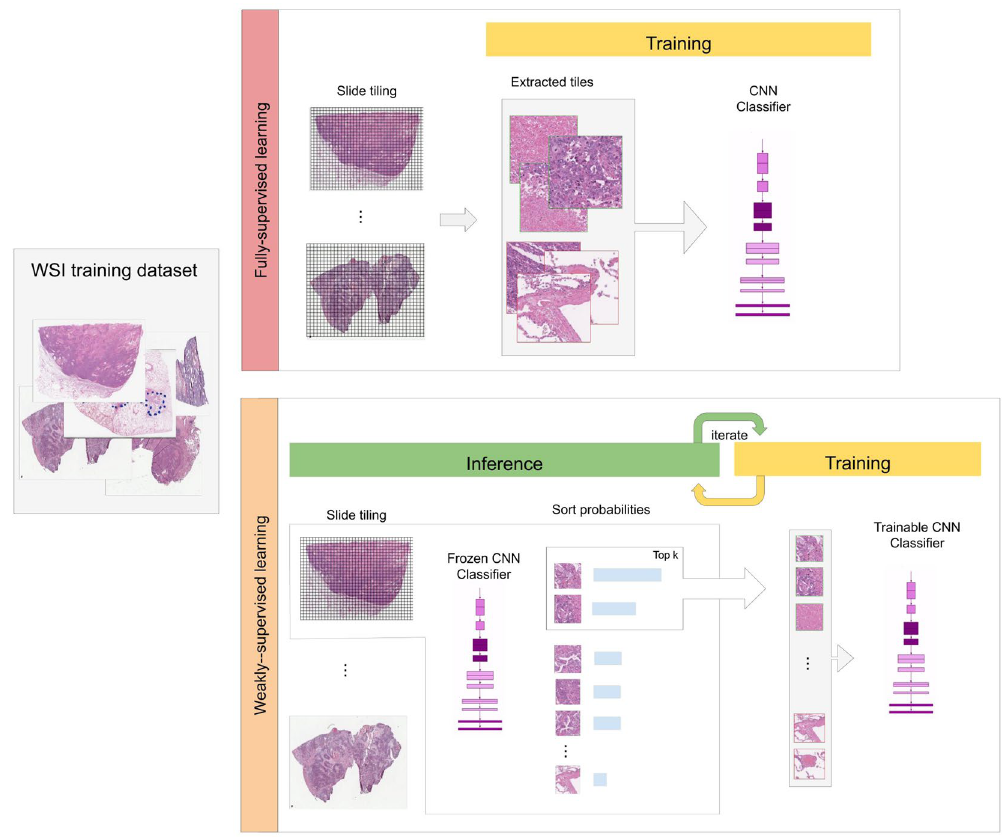
Figure 7. Overview of the two training methods: fully-supervised learning and weakly supervised learning. In the fully-supervised learning all the tiles from the WSIs were used for training and their labels were assigned directly based on the labels of the annotation regions they belonged to. In the weakly-supervised method, we iteratively alternated between inference and training. During inference, the model weights were frozen, and it was applied in a sliding window fashion on each WSI. The top k tiles with the highest probabilities were then selected from each WSI. During training the selected tiles were then used to train the